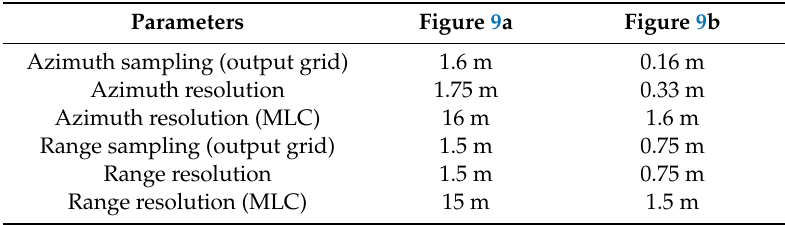
Table 5. SAR data processing parameters relevant to the results collected in Figure 9a,b.